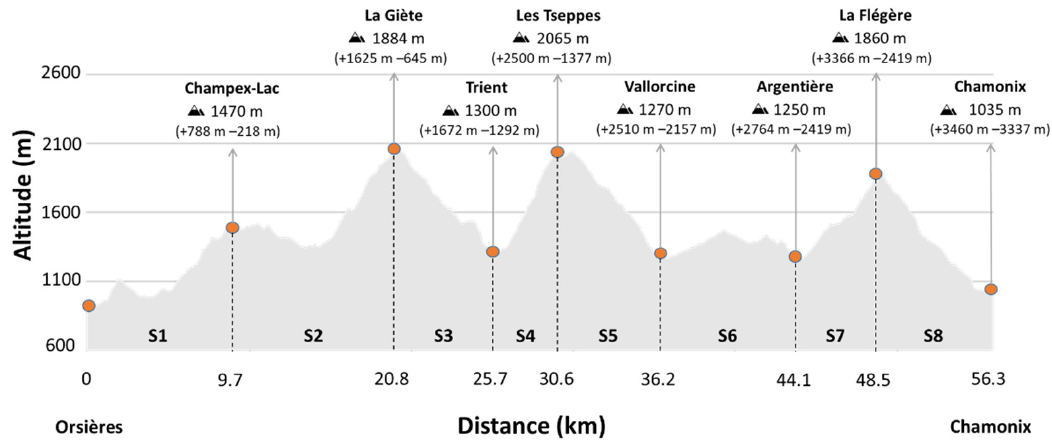
Figure 1. Profile, checkpoint altitude, cumulative elevation gain (+), and elevation loss ( − ) of the OCC ® 2017, 2018, 2019, and 2021 editions. S1–S8 = race segments. The horizontal axis represents cumulative distance, and the vertical axis represents altitude. Data obtained from the OCC ® organization.